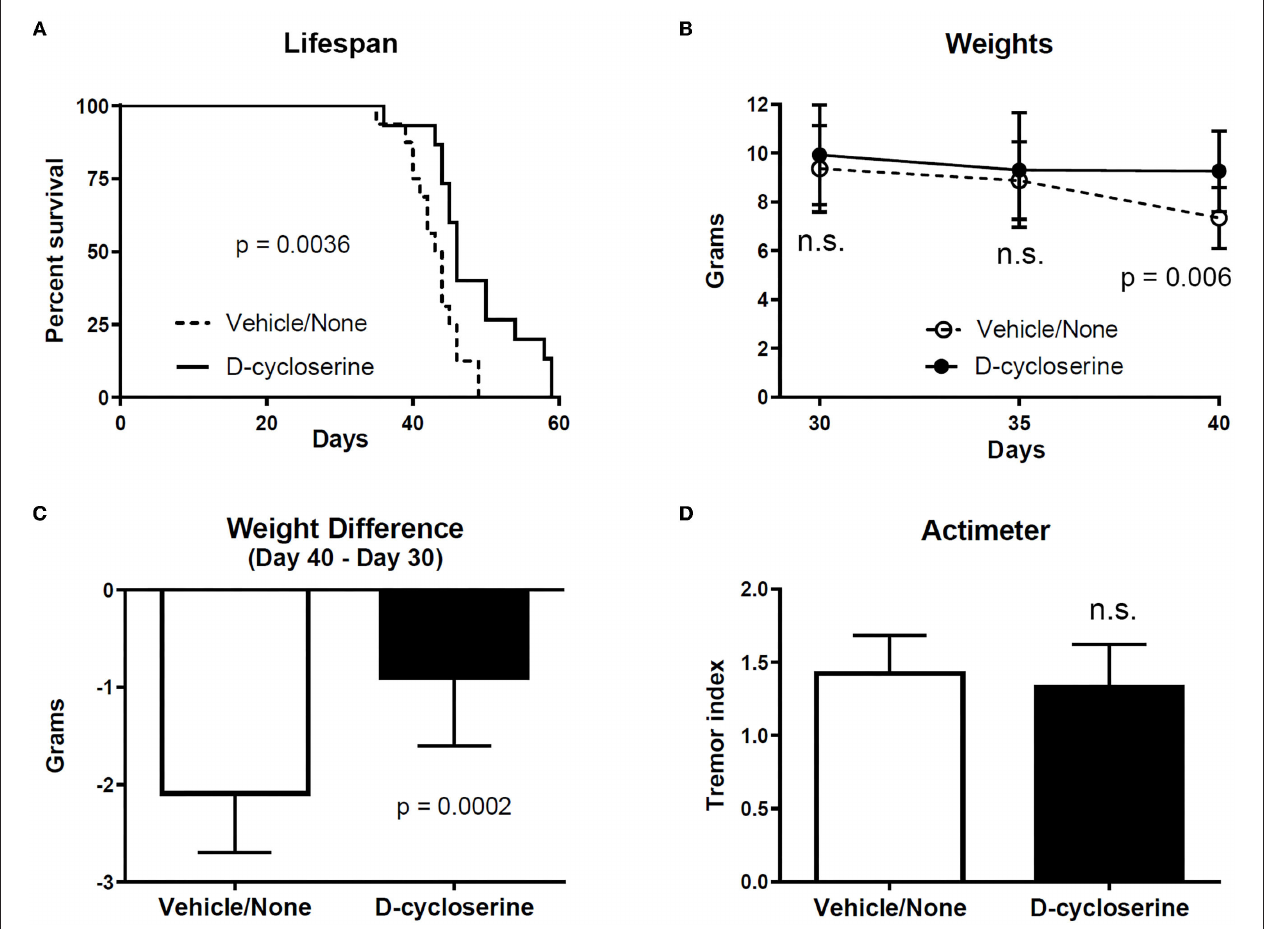
FIGURE 1 | D-cycloserine slows some parameters of disease in twitcher mice. (A) The lifespan of twitcher mice receiving D-cycloserine was significantly longer ( p = 0.0036) than twitcher mice that received vehicle or no treatment (these latter two groups were combined). Log-rank (Mantel-Cox) test. Since the data for males was not statistically different from females within each group, data for males and females were combined within the D-cycloserine group (male n = 9; female n = 6) as well as within the vehicle/no treatment group (male n = 8; female n = 8). (B) Weights (mean ± S.D.) were not different between twitcher mice given D-cycloserine and twitcher mice given vehicle/no treatment at PND 30 ( n = 16 and n = 15, respectively) and PND 35 ( n = 15 and n = 15, respectively) but were significantly greater ( p = 0.006) in twitcher mice given D-cycloserine at PND 40 ( n = 14 and n = 14, respectively) (one mouse in the vehicle group was at PND 39). Student t -test, two-tailed, corrected for multiple comparisons. (C) Weight loss (weight at PND 40 minus weight at PND 30; mean with S.D., although one mouse in the vehicle group was at PND 39) was significantly less ( p = 0.0002) for twitcher mice receiving D-cycloserine ( n = 14) vs. twitcher mice receiving vehicle/no treatment ( n = 14) (Mann Whitney, two-tailed test). (D) Twitching severity (i.e., tremor index, mean with S.D.), as measured by actimeter (23) at PND 34–36, was statistically not significant (n.s.) in D-cycloserine treated twitcher mice ( n = 14) vs. vehicle/no treatment twitcher mice ( n = 15) (two-tailed Student t -test, p ≤ 0.05 as